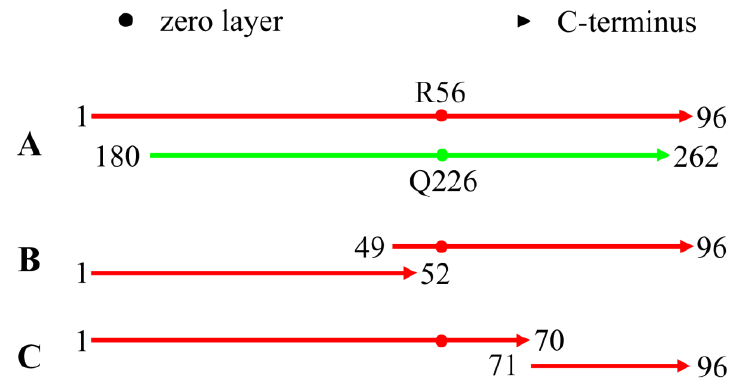
FIGURE 5. Linear alignment of Sx1A (green) and Sb2 (red) fragments used in ITC. SNAP25A was left out from the drawing for simplicity. All proteins are shown in the parallel orientation with their C-termini indicated by arrowheads. (A) The ternary complex aligns at the zero layer in which Arg56 and Gln226 residues (shown by dots) of Sb2 and Sx1A SNARE domains (Sb2 1-96 and Sx1A 180-262 ), respectively, combined with two Gln from SNAP25A form the layer. (B) In the  N complex, a binary Sx1A- SNAP25A complex is stabilized by the Sb2 49-96 fragment, which can additionally bind Sb2 1-52 to form a complex resembling the ternary SNARE complex. When the entire cytosolic domain of Sb2 1-96 binds to the  N complex, it displaces Sb2 49-96 . (C) Alternatively, the Sx1A-SNAP25A complex can be stabilized using Sb2 1-70 in lieu of Sb2 49-96 , which can bind a complementary C-terminal Sb2 71-96